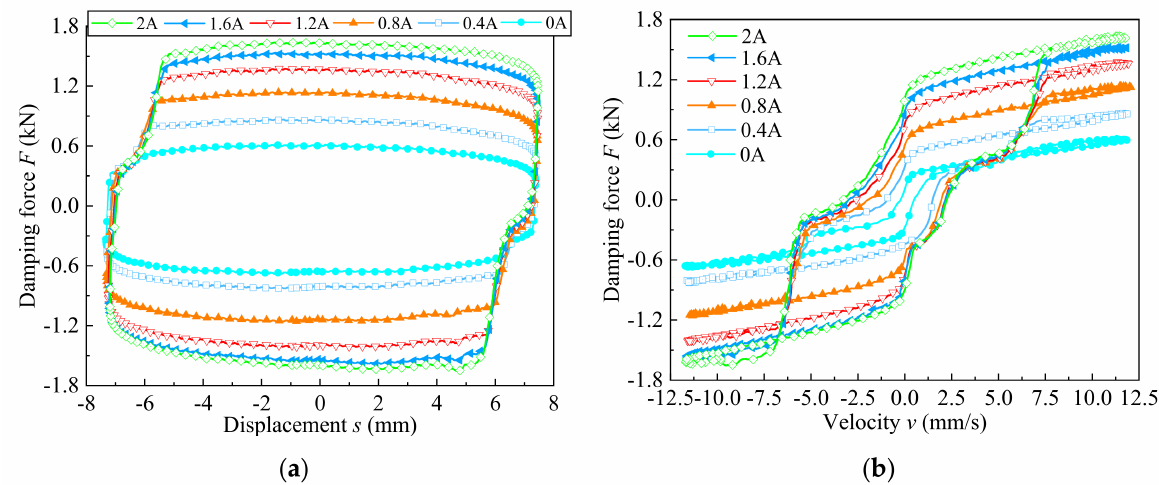
Figure 20. Damping performance of valve controlled cylinder system with radial damping gap of 1.5 mm: ( a ) force versus displacement, ( b ) force versus